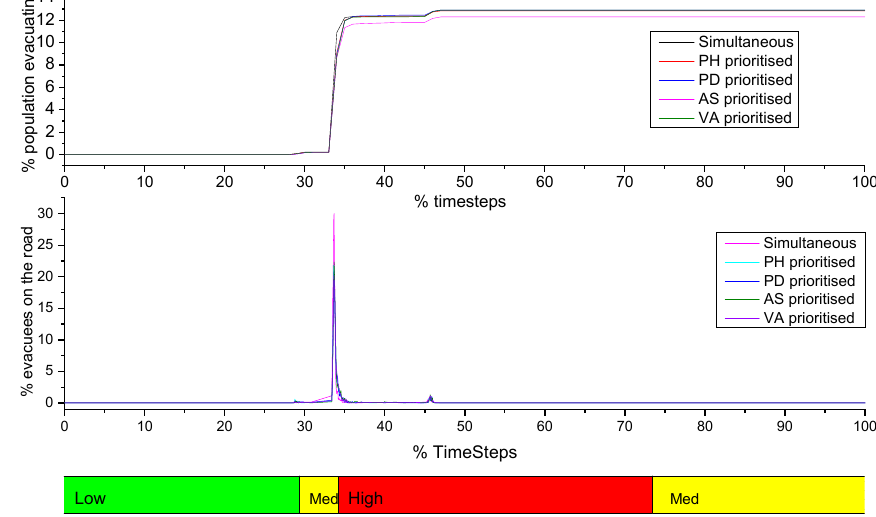
Figure 8. Overview of the simulations run for all scenarios. ( a ) The temporal accumulation of the evacuees (% of population), ( b ) the temporal distribution of the evacuees on the road (% of evacuees), (c) volcanic crisis phases setup.